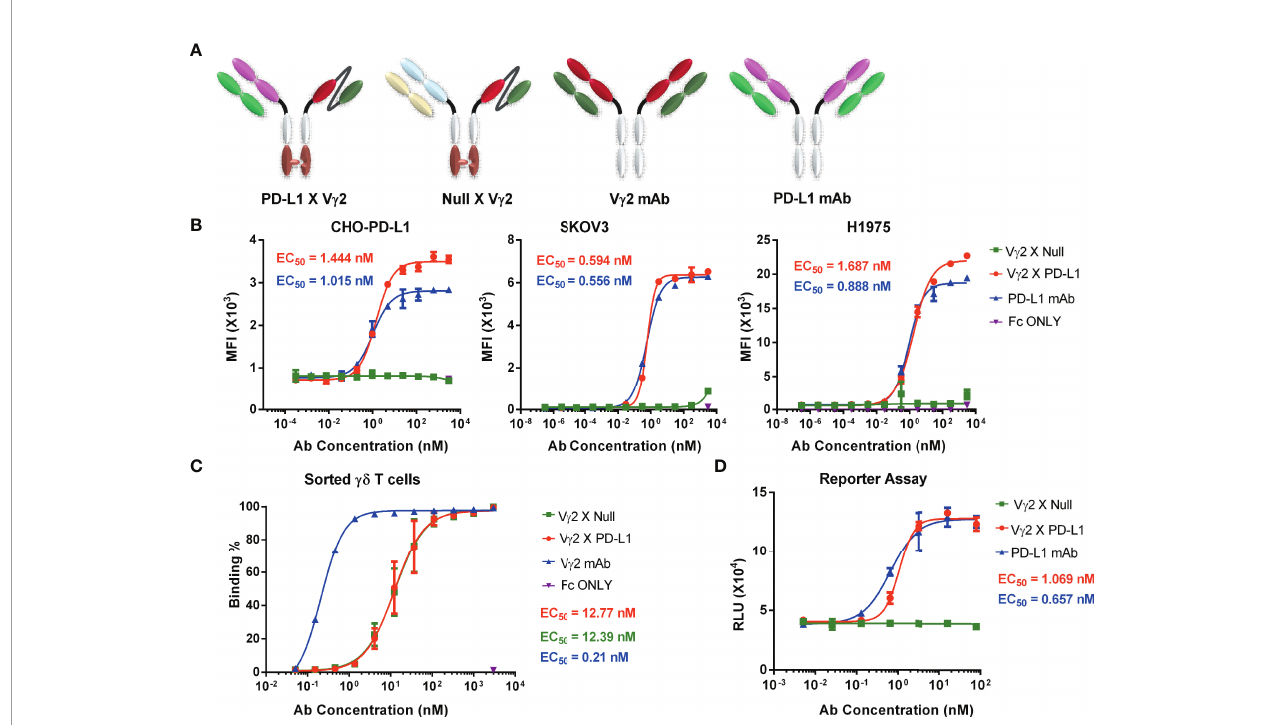
FIGURE 1 | PD-L1 x V g 2 interacts V g 2V d 2 T cells and PD-L1 expressing tumor cells, and blocks the PD1/PD-L1 interaction. (A) Structural diagrams of bispeci fi c antibodies, including PD-L1 x V g 2, Null x V g 2, V g 2 mAb, and PD-L1 mAb. A “ Knob-into-hole ” in Fc region was introduced into the bsAbs (6, 28). Besides, these four antibodies contained a modi fi ed silent Fc fragment to abolish Fc-mediated effector functions (6, 28). Please noted that V g 2 mAb and PD-L1 mAb, targeting V g 2-TCR and PD-L1, respectively, are parental monoclonal antibodies; V g 2 x Null, targeting V g 2 and fl uorescein (29), and V g 2 x PD-L1, targeting V g 2-TCR and PD-L1. The purity of these prepared antibodies was shown in Supplementary Figure 1 . (B) Binding af fi nity to PD-L1 positive cell lines. CHO-PD-L1, SKOV3, and H1975 cells were incubated with serially diluted antibodies, followed by PE-labelled mouse-anti-human Fc secondary antibody. Mean fl uorescence intensity (MFI) of the PE channel of each sample was measured to determine speci fi c binding ability (EC50). These three cell lines were PD-L1 positive shown in Supplementary Figure 2A . (C) Antibody binding af fi nity to V g 2V d 2 T cells. V g 2V d 2 T cells were negatively enriched from PBMC cultures treated by Zol+IL2 for 14 days. Then, cells were incubated with serial dilutions of indicated antibodies, followed by APC-conjugated mouse-anti-human Fc secondary antibody. APC positive populations were measured to demonstrate speci fi c binding (EC50). The representative fl ow cytometry plots related (B, C) were shown in Figure 2 . (D) The ability of PD-L1 x V g 2 to block PD1/PD-L1 signaling (EC50) was similar to that of the parental PD-L1 mAb using a cell-based reporter assay. Data were presented as Mean ± SD from n = 3 independent experiments (B, D) , pooled from n=1 biological replicate for V g 2 mAb, n=6 biological replicates for V g 2 x Null and V g 2 x PD-L1 (C) . Reported EC 50 values were calculated from non-linear best fi ts (B – D)